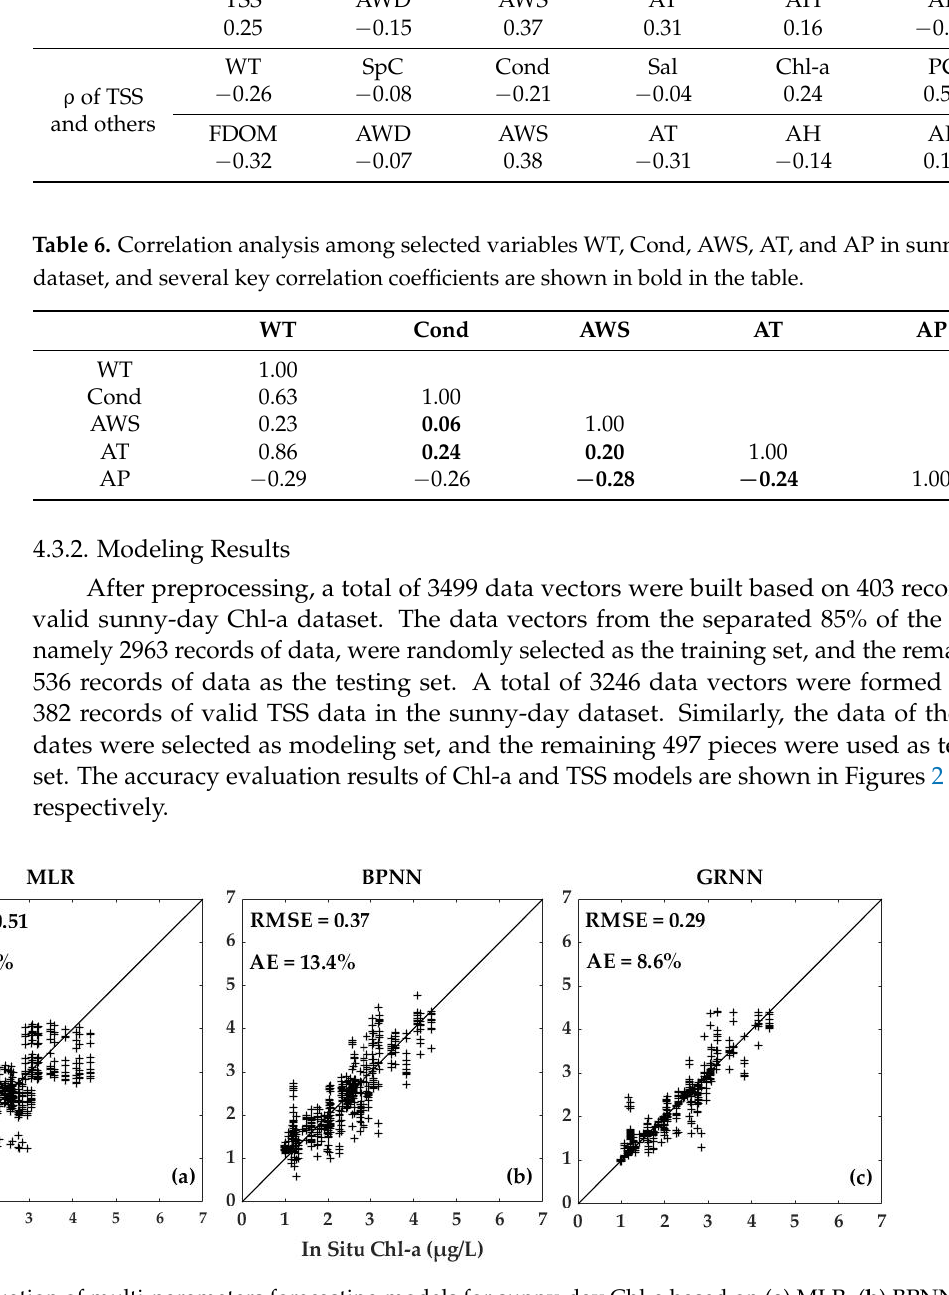
Figure 2. Accuracy evaluation of multi-parameters forecasting models for sunny-day Chl-a based on ( a ) MLR, ( b ) BPNN, and ( c ) GRNN.